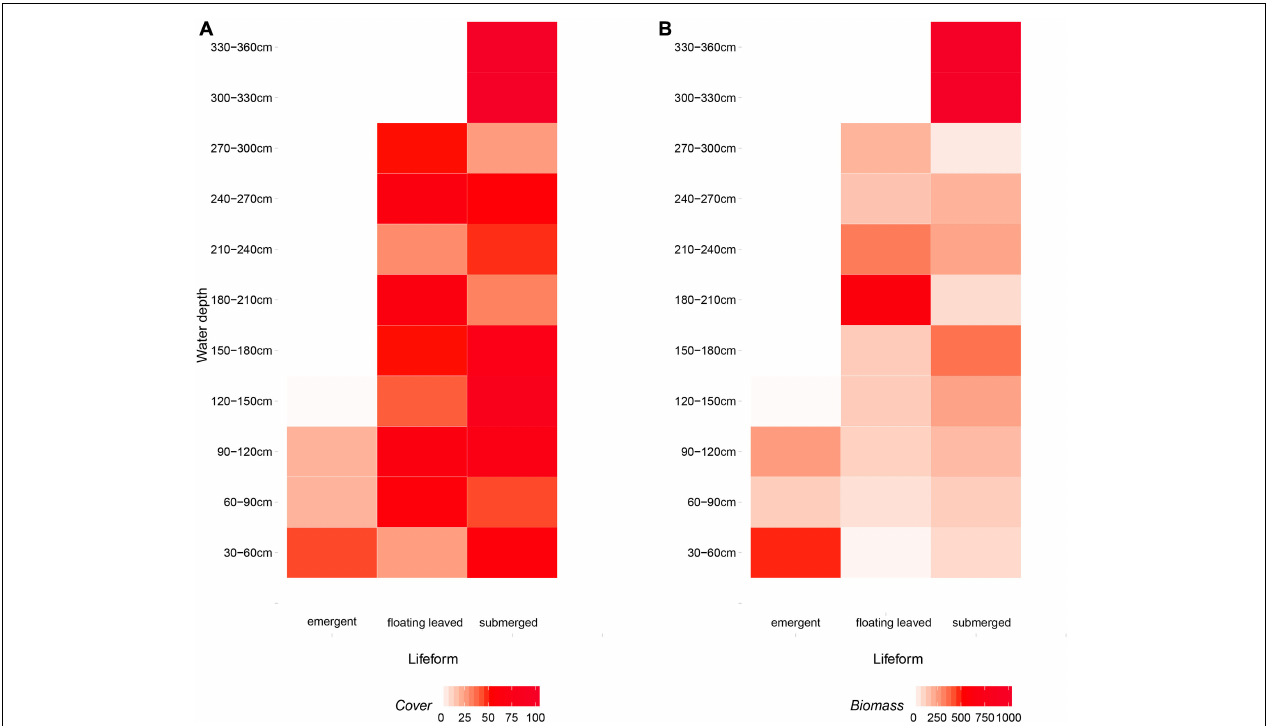
FIGURE 7 | The distribution of (A) coverage and (B) biomass of three life-form macrophytes (emergent, floating-leaved, and submerged plants) on the gradients of water depth. Free-floating plants were excluded because they drifted